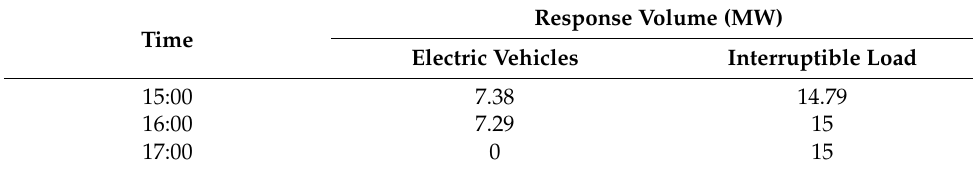
Table 8. Deterministic demand response volume.